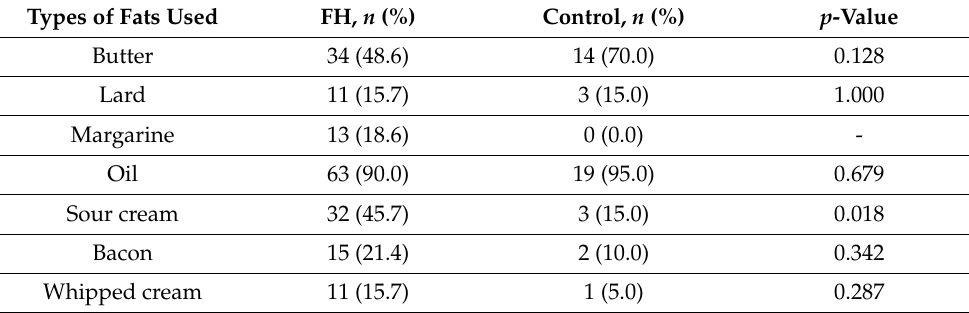
Table 4. Fats used for cooking or consumed in the two studied